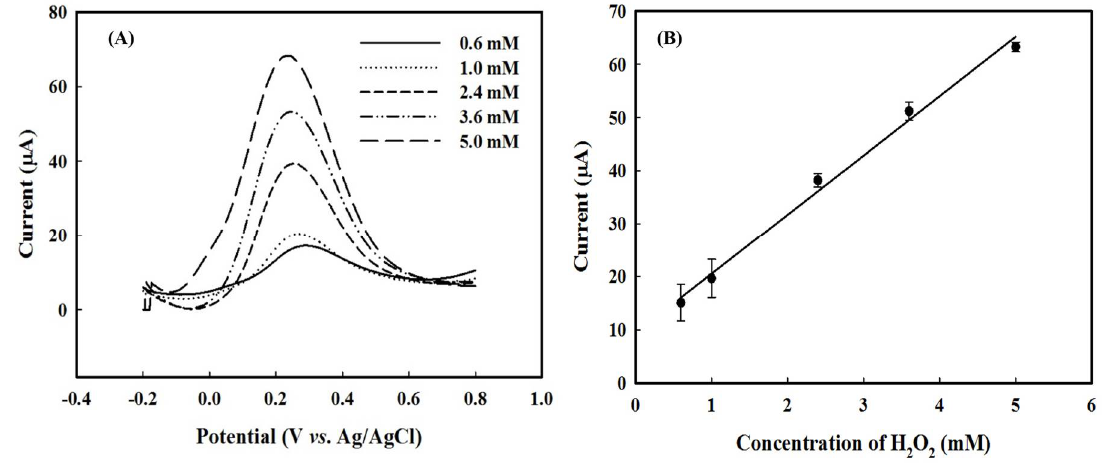
Figure 3. ( A ) The profile of differential pulse voltammetry (DPV) for electrode in response to H 2 O 2 ; ( B ) The nice linear relationship between peak current and molar concentration of H 2 O 2 , where data were collected with a single electrode from triple-measurements for each concentration of H 2 O 2 .